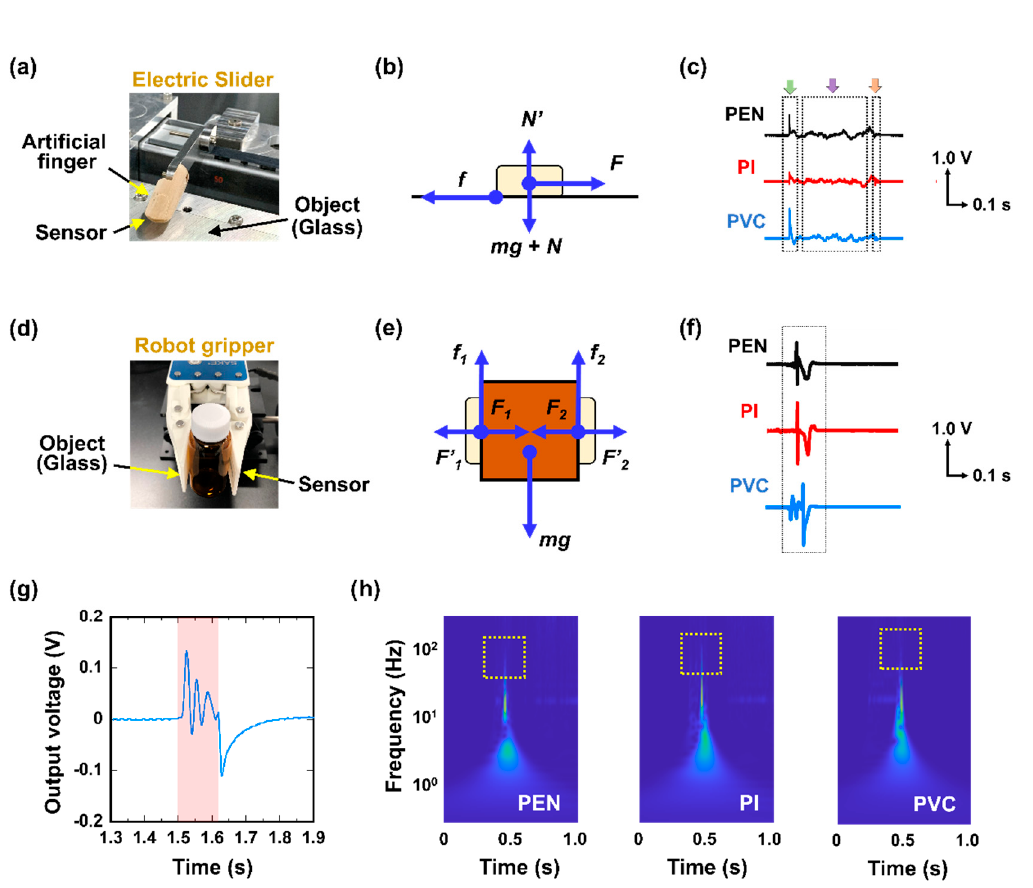
Figure 4. Object slippage detection by the soft sensor: ( a ) Measurement setup showing the artificial finger and the electric slider; ( b ) Friction model based on the equation of motion; ( c ) Signals detected by the sensors in each passivation layer (PEN, PI, and PVC); ( d ) Measurement setup with the robotic gripper; ( e ) Friction model developed from the equation of motion; ( f ) Signals detected by the robotic gripper sensors for each passivation layer (PEN, PI, and PVC); ( g ) Voltage response of the PEN film during object slippage (magnification of (f)). The stick-slip (S-S) spectra are shown in red; ( h ) S-S spectra of the piezoelectric voltage signals for different fractional layers over a range of frequencies. The sensor generated voltage in response to the dynamic friction caused by the object slippage.